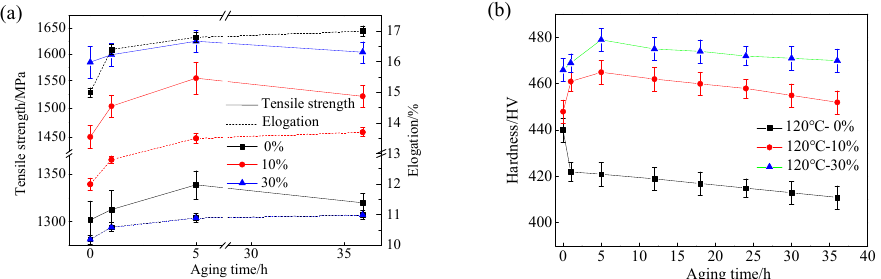
Figure 10. Tensile strength, elongation ( a ), and hardness ( b ) of the experimental steel after aging at 120 °C for various time periods.